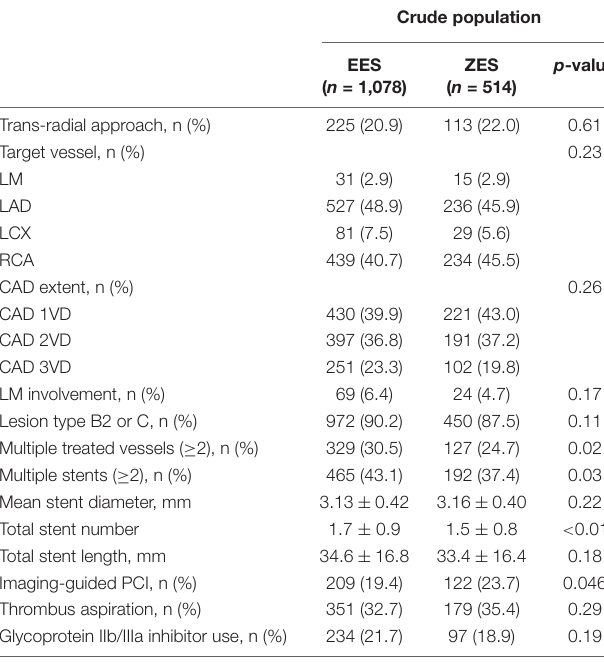
TABLE 2 | Angiographic and procedural